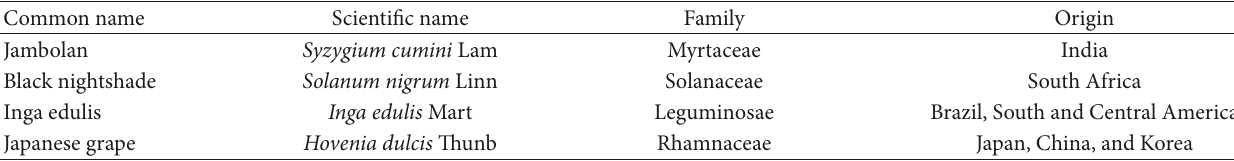
Table 1: List of the four fruits included in this